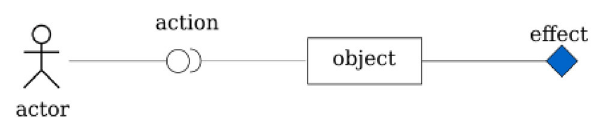
FIGURE 3 | A graphical representation of an affordance. An object accepts any action that fits its interface (shown on object’s left), and produces the specified effect (shown on object’s right). Any actor capable of performing the expected action on this object can produce the described